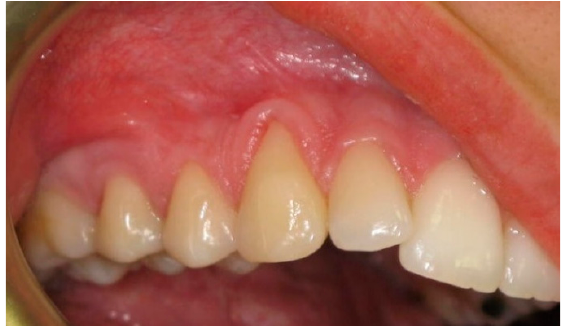
Figure 1. Right canine and first premolar with gingival recession at baseline.